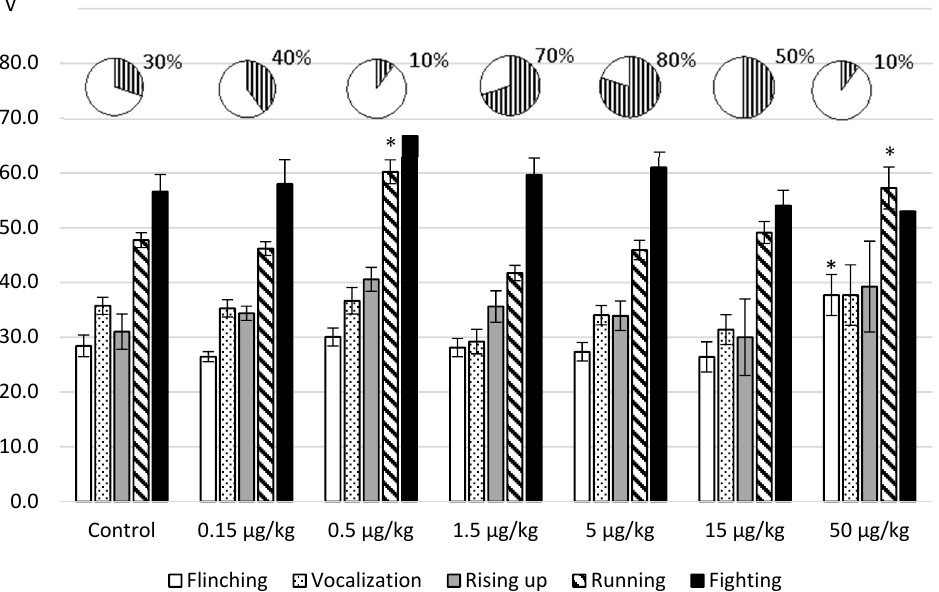
Figure 3. The threshold values (V, M ± m) of the aggressive–defensive behavior of rats in foot-shock test after intraperitoneal administration. Note: the obtained data were analyzed by ANOVA and the post hoc Dunnett test; the round diagrams: the fighting rate (shaded) as a percentage of the total number of samples: two stimulation tests were carried out on each of ten rats in pairs (all samples — to 20).* – p < 0.05–0.001 in comparison with the control values.